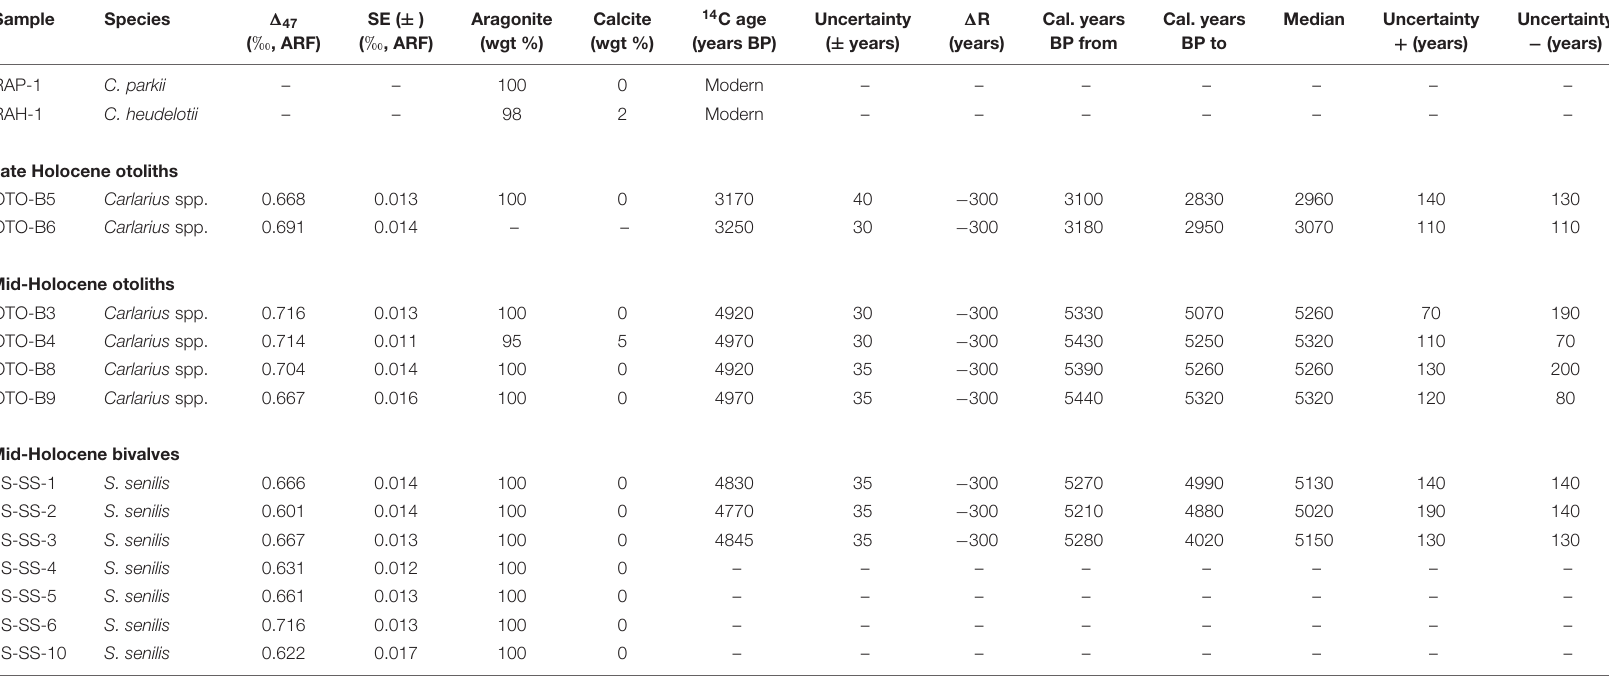
TABLE 2 | Clumped isotope, mineralogy and radiocarbon data of the modern and Holocene